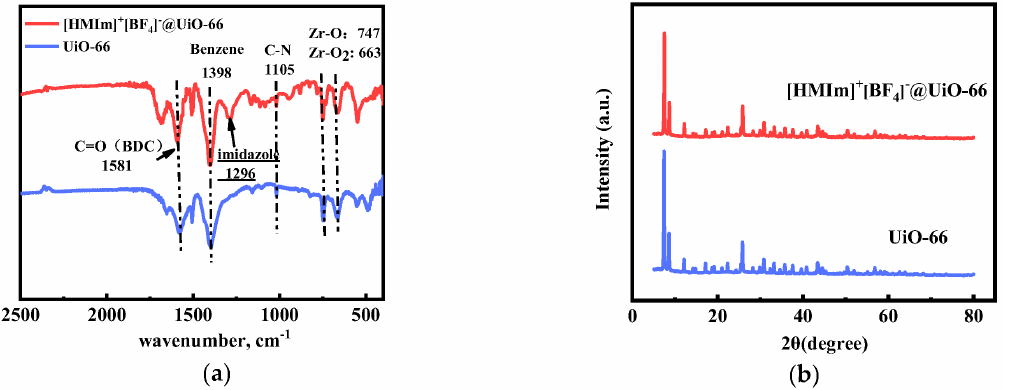
Figure 2. ( a ) FT − IR spectra of UiO − 66 and [HMIm] + [BF 4 ] − @UiO − 66; ( b ) PXRD patterns of UiO − 66 and [HMIm] + [BF 4 ] − @UiO −